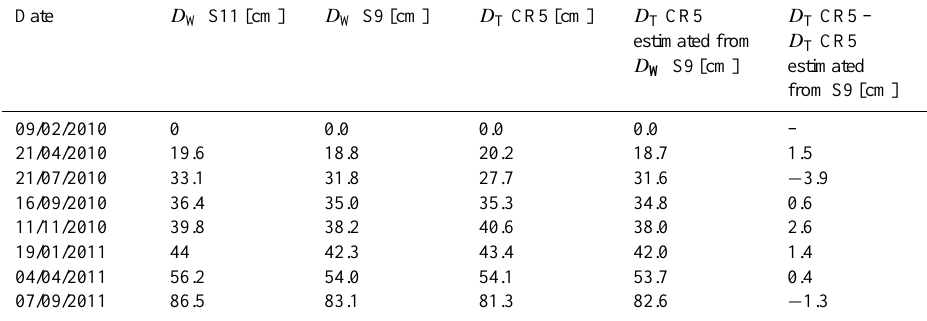
Fig. 11. (a) Chart comparing total displacement recorded at wire extensometers S11 and S9, from December 1999 to August 2004, and (b) chart comparing total displacement calculated for extensometer S9 and total displacement calculated for CR5 for the period from February 2010 to September 2010. Red lines show the optimum linear fit to the data. Dashed lines show straight lines with a slope of 1 : 1. Table 5. Comparison of GB-SAR LOS displacements ( D LOS ) measured for CR5 and CR7 and total displacements measured by wire extensometers ( D W ) for S11 and S2,